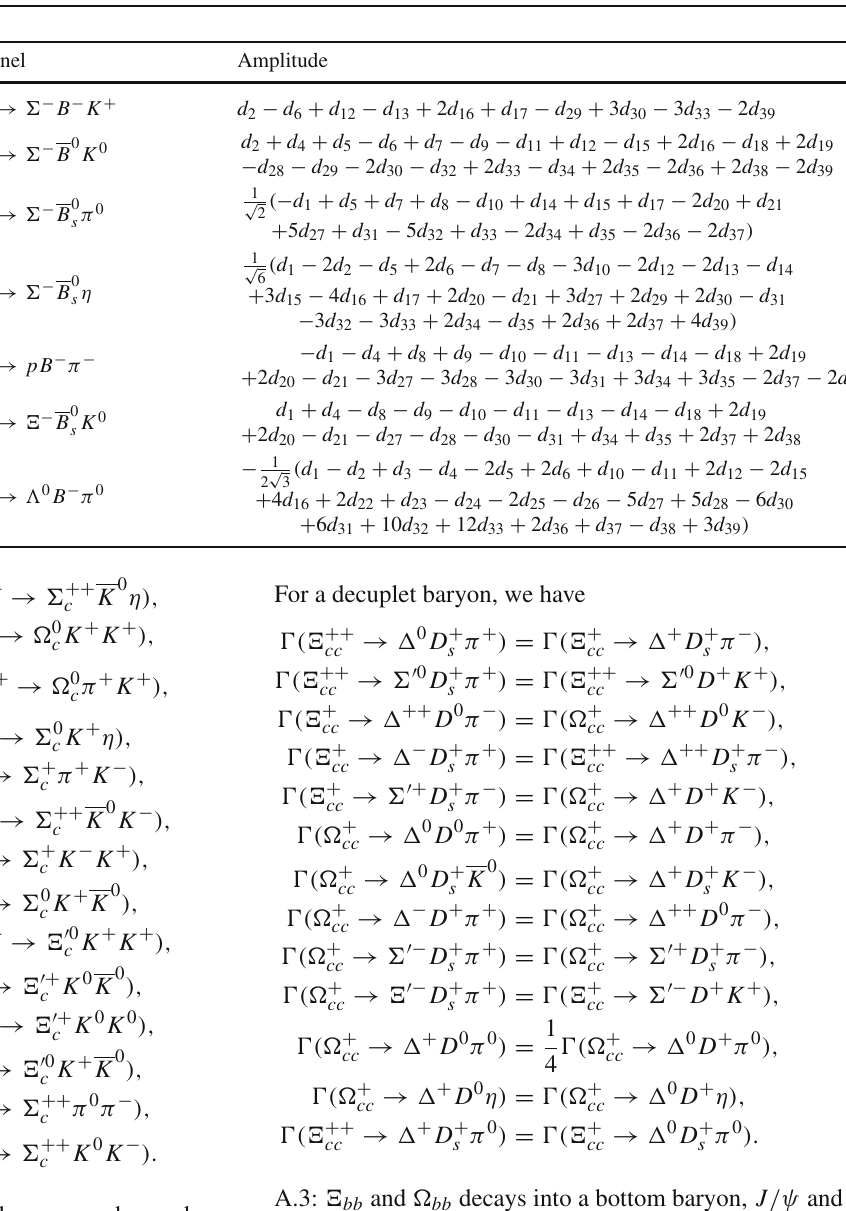
A.2: (cid:2) cc and (cid:5) c decays into a octet baryon , a charmed meson and a light meson